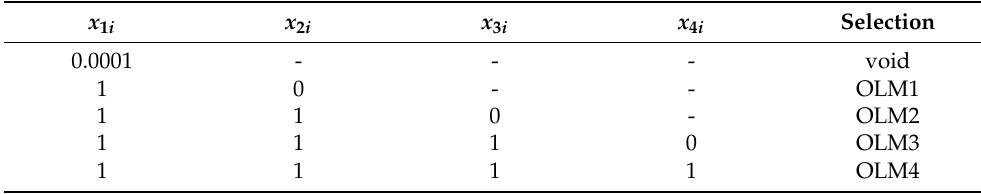
Table 3. Adopted interpolation